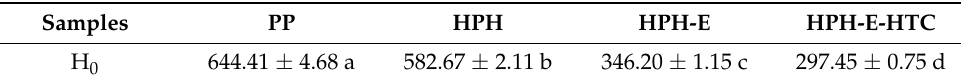
Table 2. Surface hydrophobicity (H 0 ) of peanut protein (PP), high pressure homogenized pro- tein (HPH), high pressure homogenized and enzyme (E) treated protein (HPH-E), and HPH-E- hydrothermally cooked (HPH-E-HTC) protein.